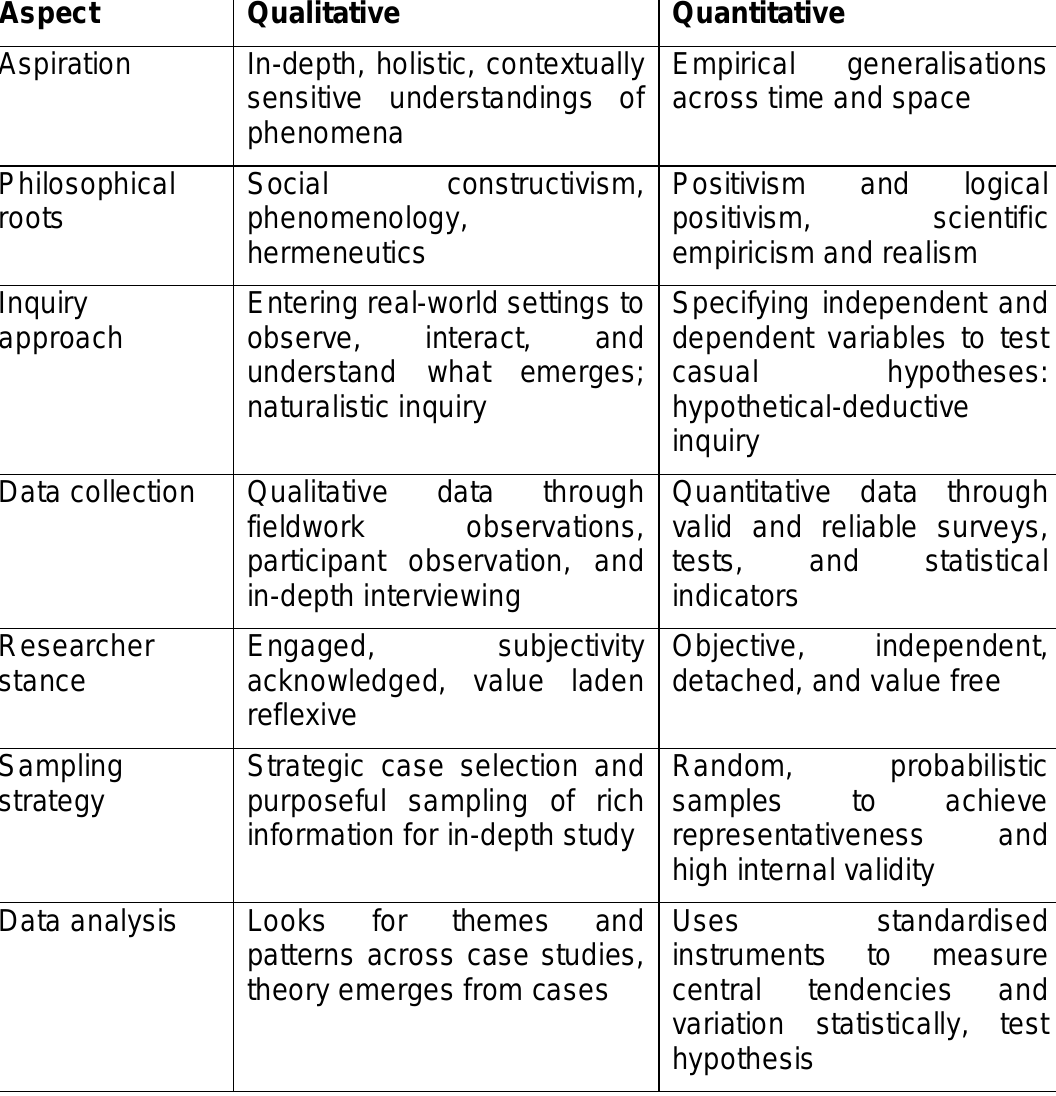
Table 3.3: Key characteristics of qualitative and quantitative approaches